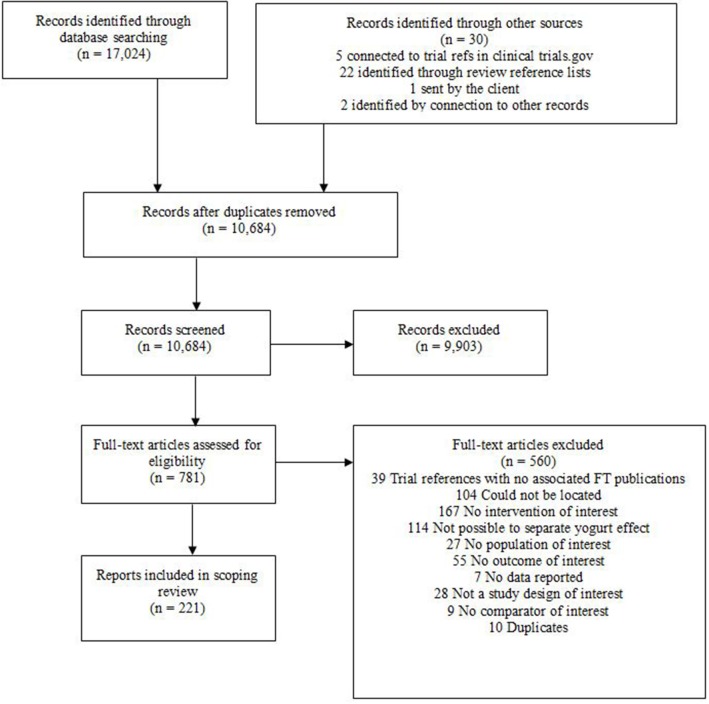
PRISMA flowchart.